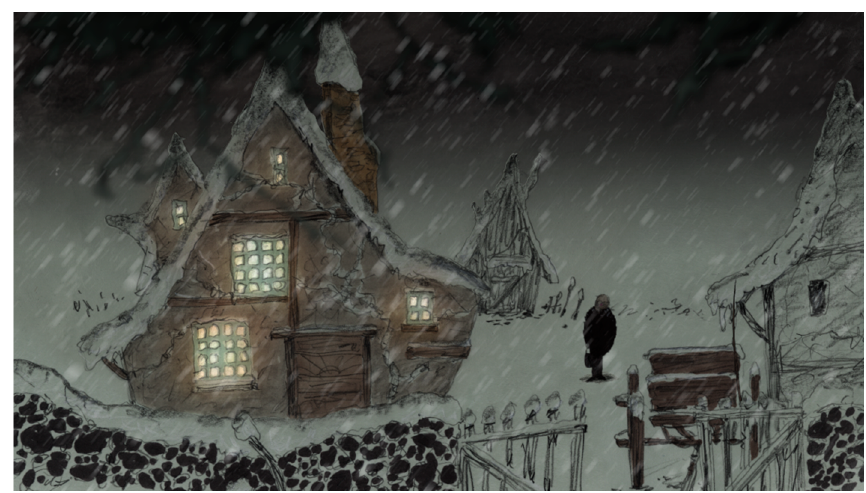
Figure 1. ©YAMAMURA Animation/SHOCHIKU. Figure 1. © YAMAMURA Animation /